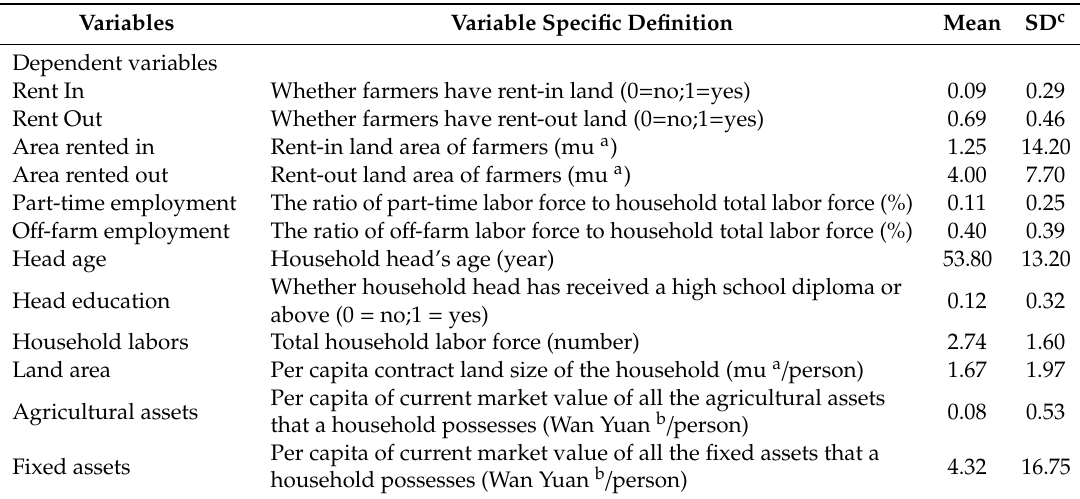
Table 1. The definition and descriptive statistical of the